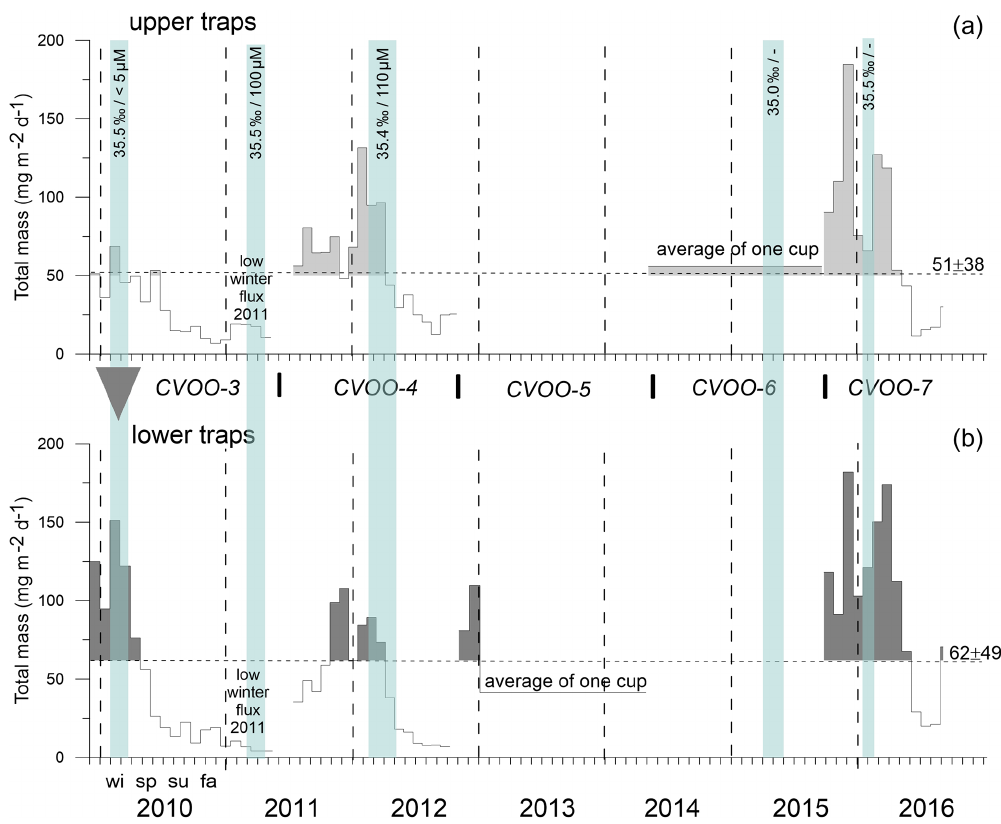
Figure 4. Total mass fluxes between 2009 and 2016 for the upper (a) and the lower (b) traps and low-oxygen/low-salinity events during winter of a duration of 1 month and longer (vertical blue bars, with salinity and oxygen concentrations). Means with SD (horizontal dashed lines) were only slightly above typical oligotrophic flux values (ca. 50mgm − 2 d − 1 ; Bory et al., 2001; Fischer et al., 2010; Korte et al., 2017). Peak fluxes (above the means) are shaded grey to indicate maxima during late fall and winter. The grey triangle indicates “flux focusing” during the winter ACME of 2010 (Fischer et al., 2016). Note the low (oligotrophic) fluxes during winter 2011 far below the means. Horizontal dashed lines indicate mean fluxes; vertical lines separate years; wi, sp, su and fa indicate the